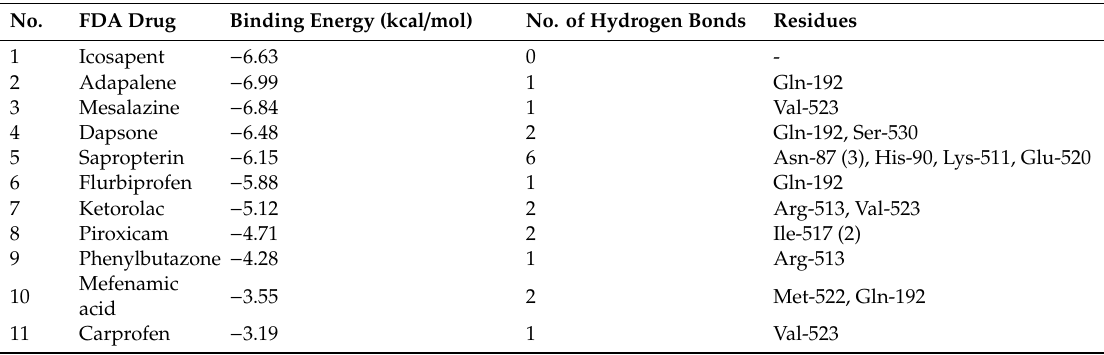
Table 4. Binding pattern for the PTGS2 structure (Protein Data Bank (PDB) identifier (ID): 5IKV) with their targeting drugs. FDA—Food and Drug